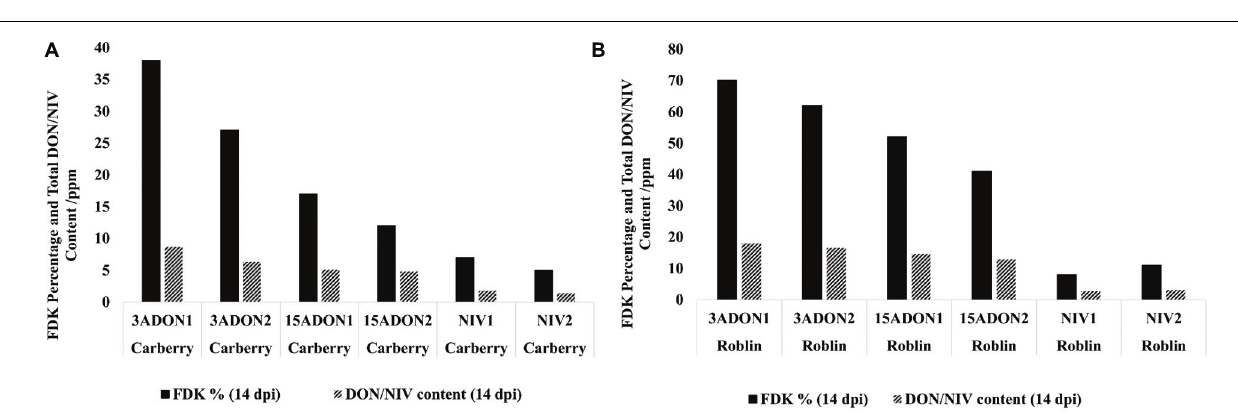
FIGURE 5 | Fusarium damaged kernel (FDK) percentage and total terminal deoxynivalenol (DON) or nivalenol (NIV) content in (A) moderately resistant cultivar Carberry and (B) susceptible cultivar Roblin after inoculating with different chemotypes of Fusarium graminearum at 14 days